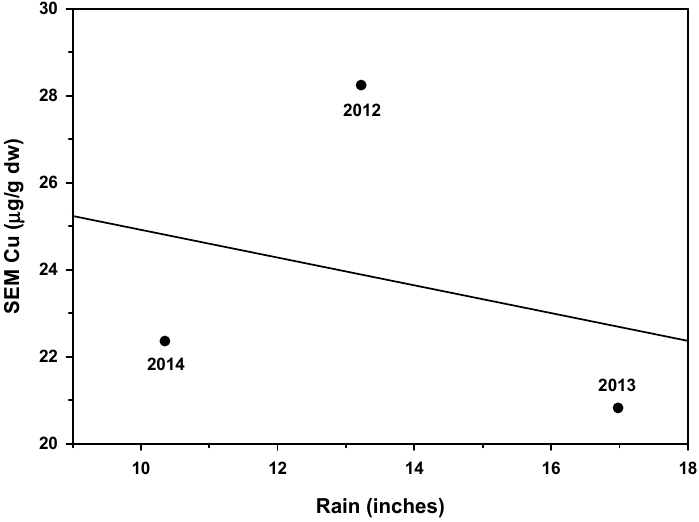
Figure 27. Linear regression results of the total rain in inches at NWS site SACRAMENTO 5 ESE from the water years 2012–2014 versus the mean SEM Cu sediment concentration from all Cache Slough sample sites during the same years (r 2 = 0.073, p =